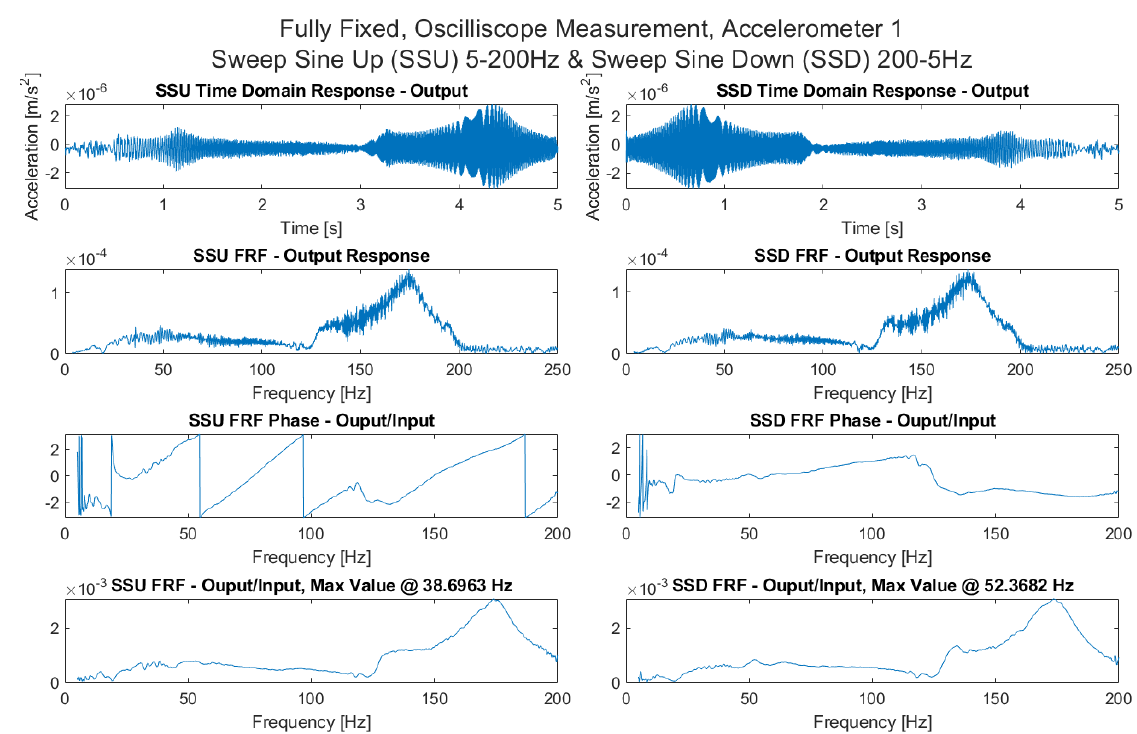
Figure A16. Swept sine inputs: Oscilloscope measurements: Accelerometer Figure A16 . Swept sine inputs: Oscilloscope measurements: Accelerometer 1 .